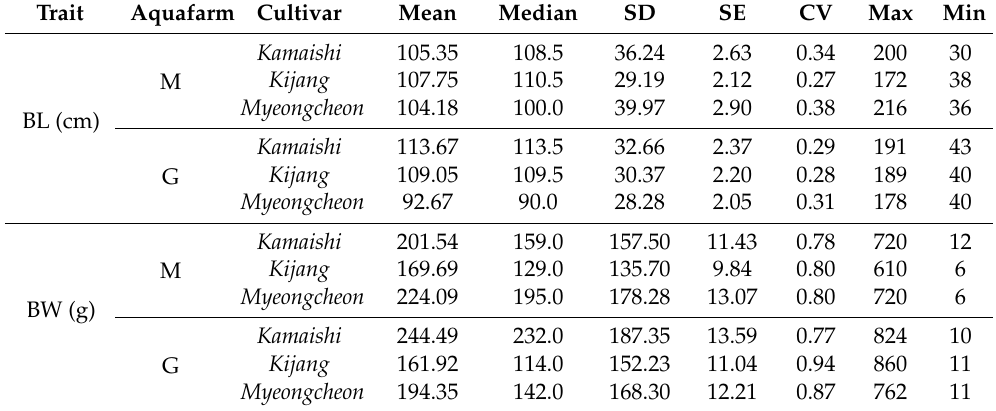
Table 2. Mean, median, standard deviation (SD), standard error (SE), coefficient of variation (CV), maximum (Max), and minimum (Min) values of blade lengths (BL), and blade widths (BW) for three cultivars of U. pinnatifida at Myeongcheon (M) and Gyedo (G) aquafarms between January and May 2003.